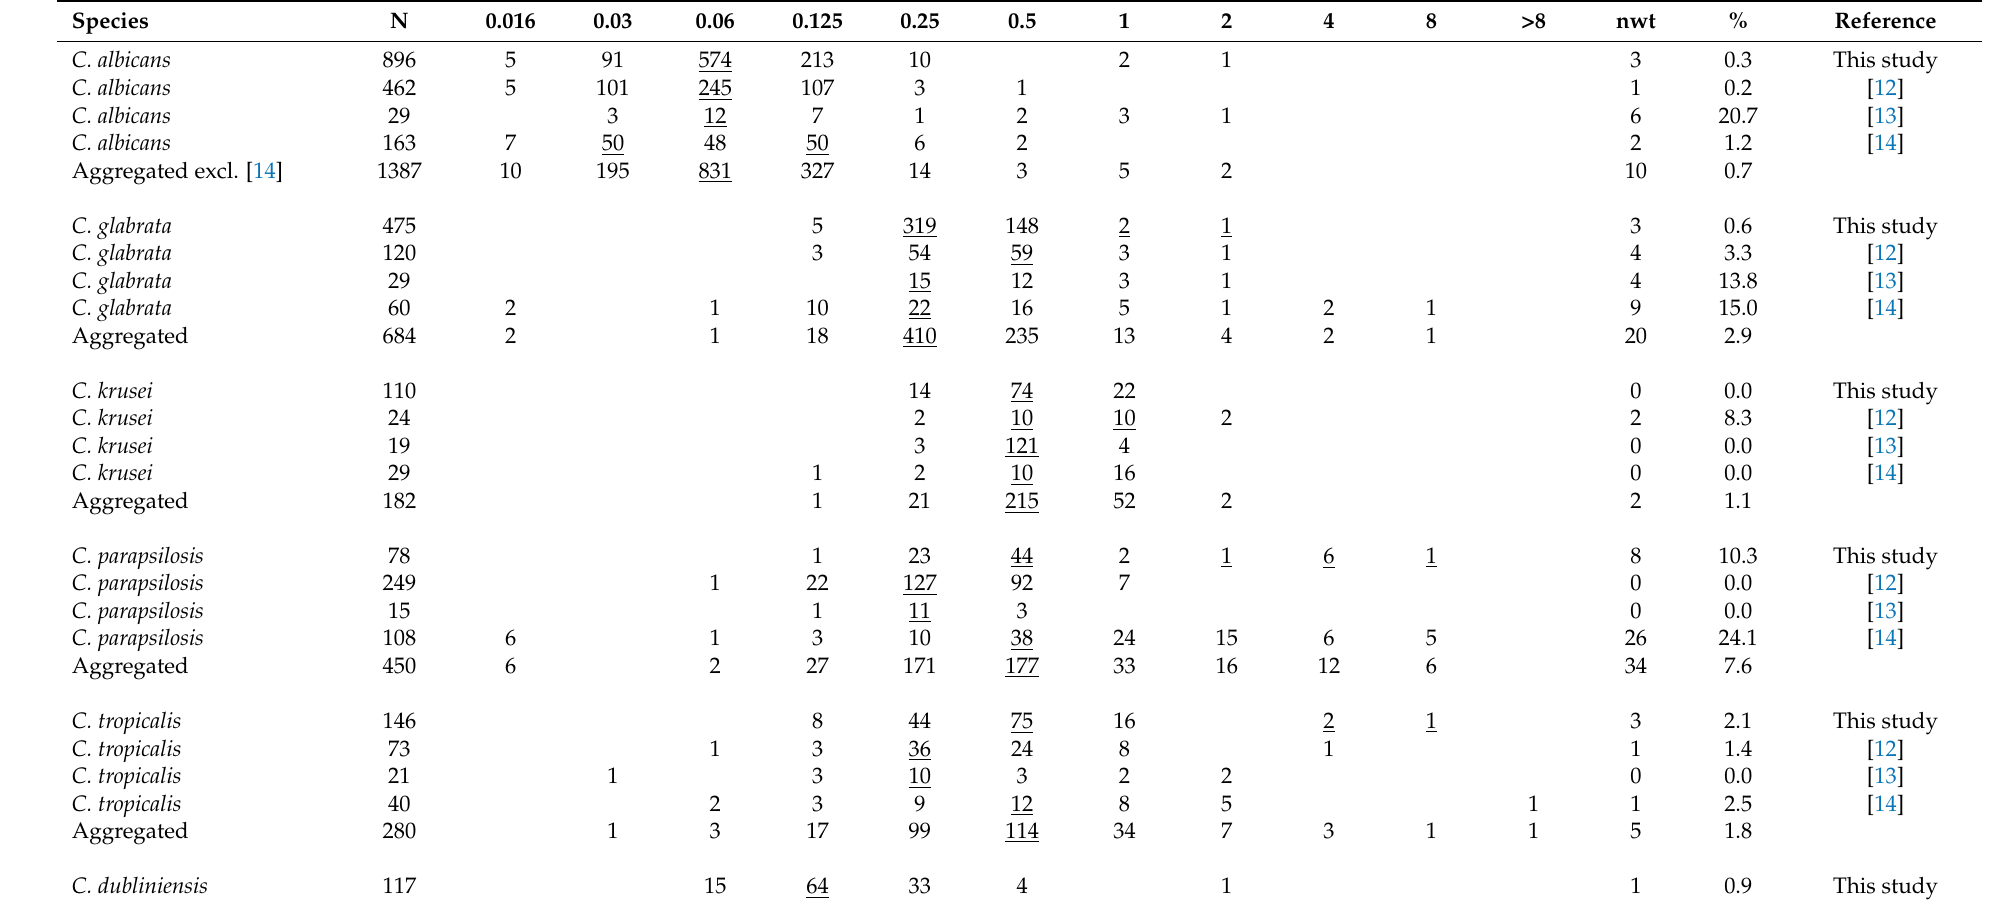
Table 3. Ibrexafungerp MICs for the five most common Candida species isolates (3146 in total) from this study (n = 1705) and from three additional studies (two single-centre studies [12,13] and a multicentre study [14]). The Pfaller et al. study [13] included isolates selected to include wild-type and fluconazole and echinocandin-resistant strains, whereas the two other studies included unselected clinical isolates. The modal MIC is highlighted in underlined font. The consensus WT-UL is indicated by a dashed vertical line (Table